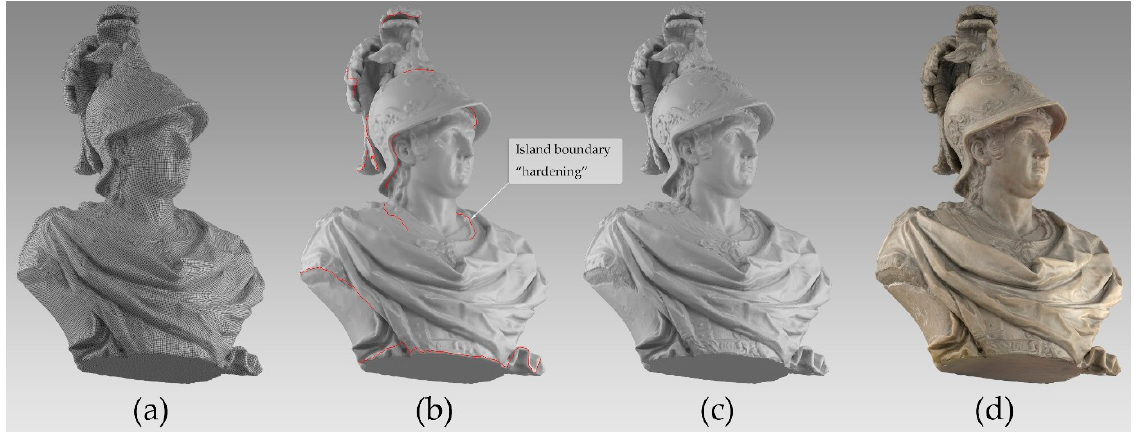
Figure 24. Summary of the pipeline: quad-dominant model ( a ); parameterization and ‘hardening’ ( u,v ) boundary islands ( b ); baked normals from high-poly master model ( c ); final 3D textured model ( d